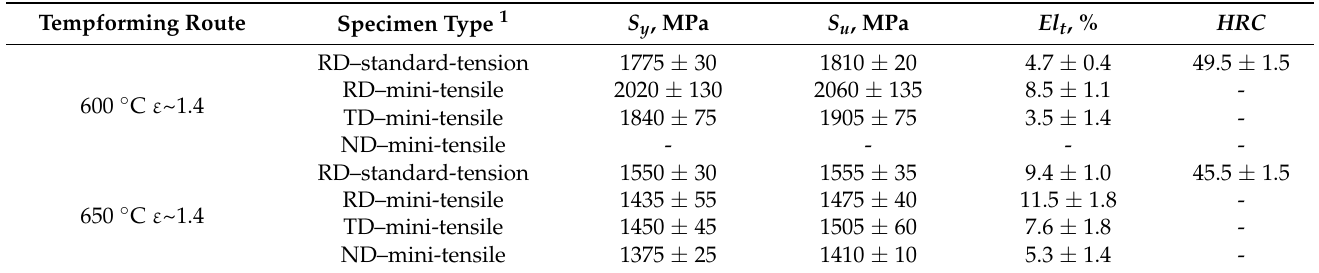
Figure 5. Engineering stress–strain curves of tempformed (TF) steel obtained for different orientations of tensile specimens at ( a – c ) 600 ◦ C and ( d – f ) 650 ◦ C. The continuous and dashed lines indicate engineering stress–strain curves obtained on the mini-tensile and standard specimens, respectively. Table 5. Average values of the static mechanical properties and their standard deviations of the tempformed steel along different